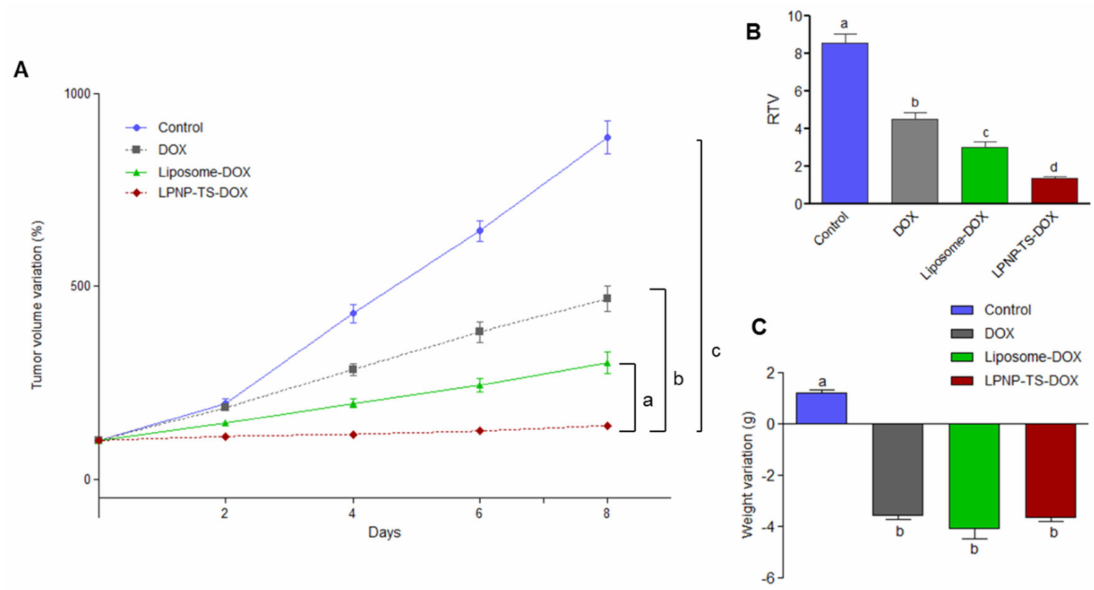
Figure 9. ( A ) Antitumor effect of blank-NLC (control), free DOX, Liposome-DOX, and NLP-TS-DOX on the growth of 4T1 tumor implanted into BALB/c mice. Each animal received by IV injection a dose of 5 mg/kg per day every other day (total of four administrations). Results are presented by the mean ± standard deviation (n = 7). Growth curves were analyzed by One-way ANOVA, followed by Tukey’s test. a Represents significant differences ( p < 0.01) between NLP-TS-DOX and Liposome-DOX treatments. b Represents significant differences ( p < 0.001) between NLP-TS-DOX and DOX treatments. c Represents significant differences ( p < 0.001) between NLP-TS-DOX and Control treatments. ( B ) RTV analysis of Control, DOX, Liposome-DOX, and NLP-TS-DOX groups. Results are presented by the mean ± standard deviation (n = 7). Different letters indicate significant differences among groups ( p < 0.05). ( C ) Body weight variation between D0 and D8. Results are presented by the mean ± standard deviation (n = 7). Different letters indicate significant differences among groups ( p <